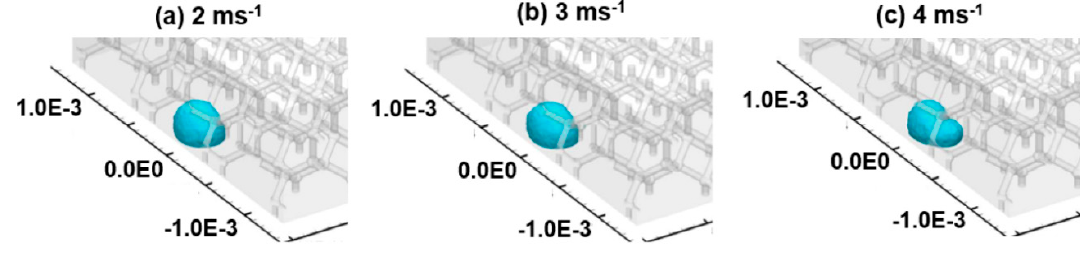
Figure 8. Initial behaviour of water droplet at 3 ms − 1 air flow rate; ( a ) 0.5 ms, ( b ) 1.5 ms, ( c ) 3.0 ms, ( d ) 6.0 ms and ( e ) 15 ms after liquid water injection.